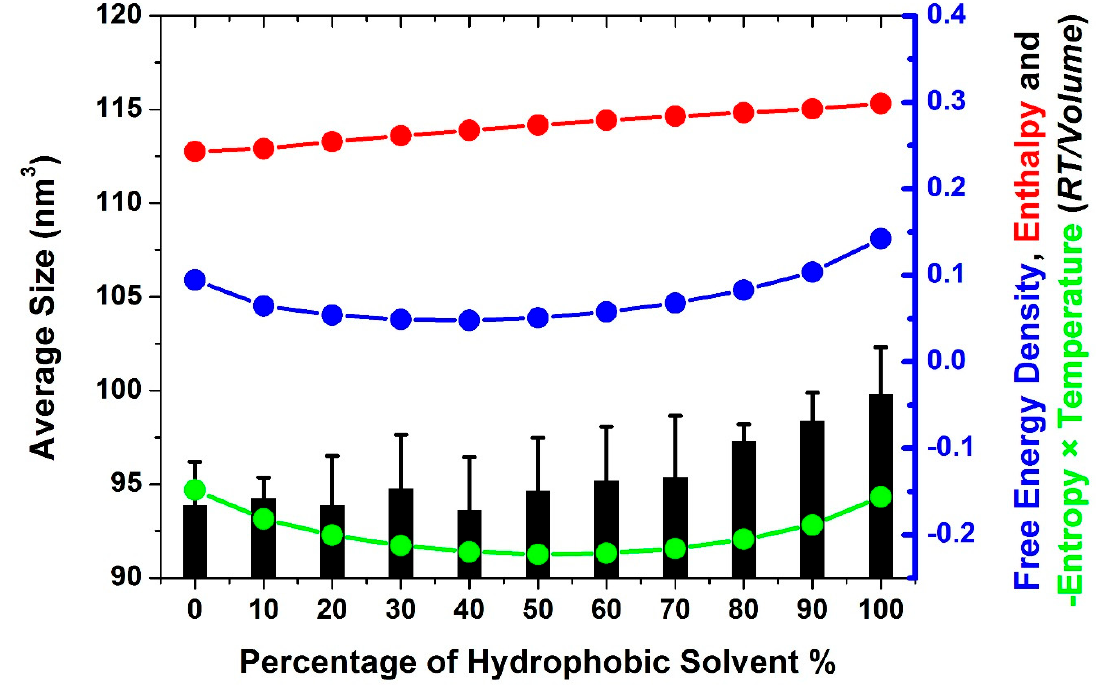
Figure 4. Average size, free energy density, enthalpy and -entropy × temperature in systems with different doping percentages of hydrophobic solvent, which are denoted by a black column, blue line, red line, and green line, respectively.